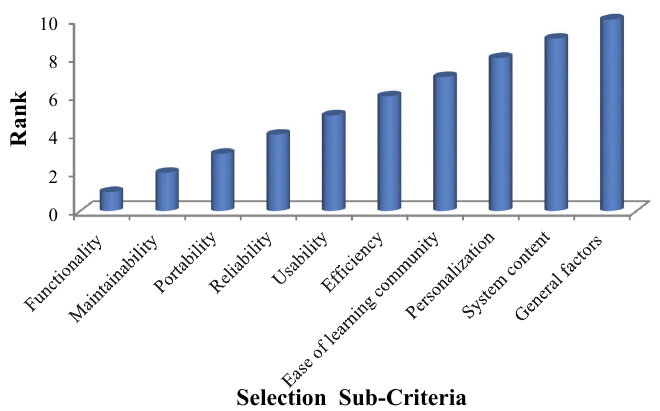
Fig. 2. Rankings of E-learning websites selection sub-criteria